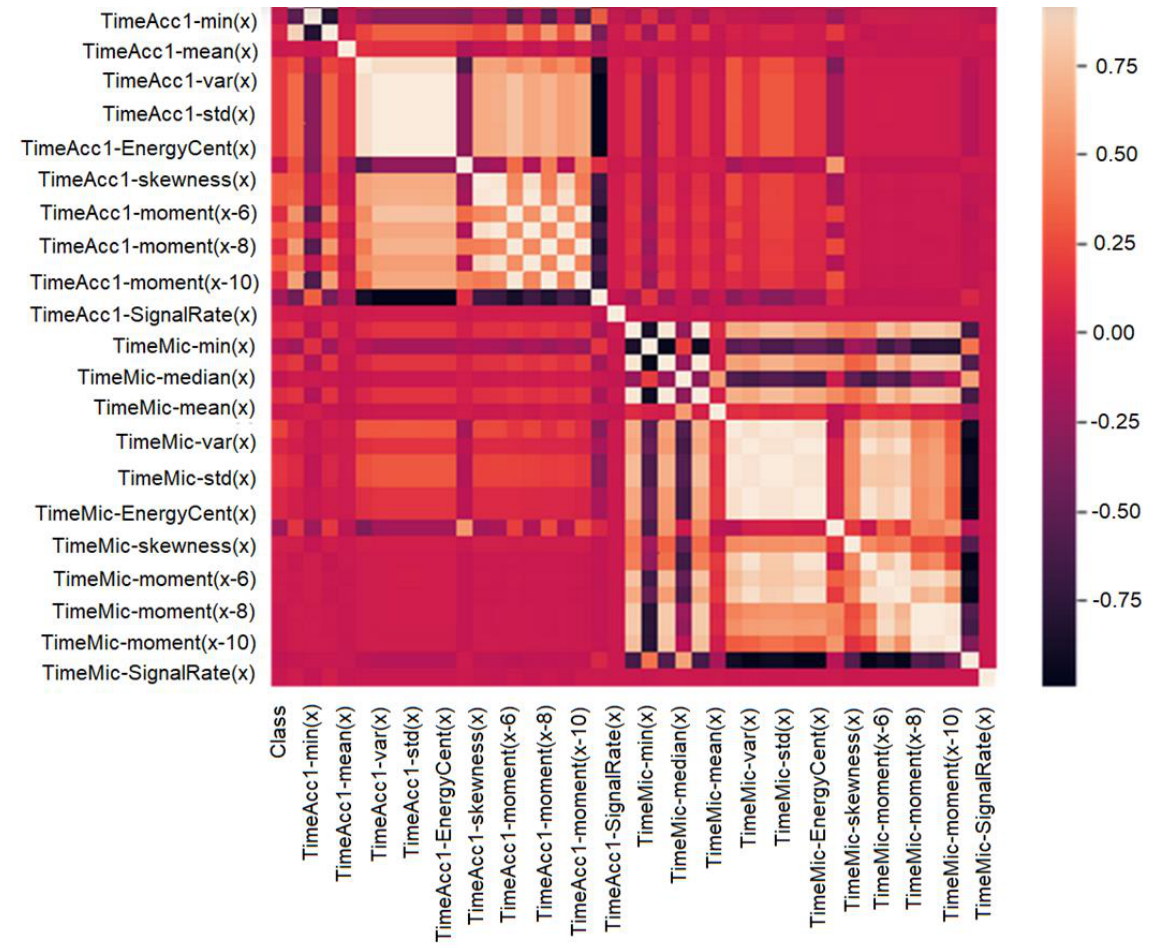
Figure 5. Graphical visualization of the correlation table (Pearson’s method).